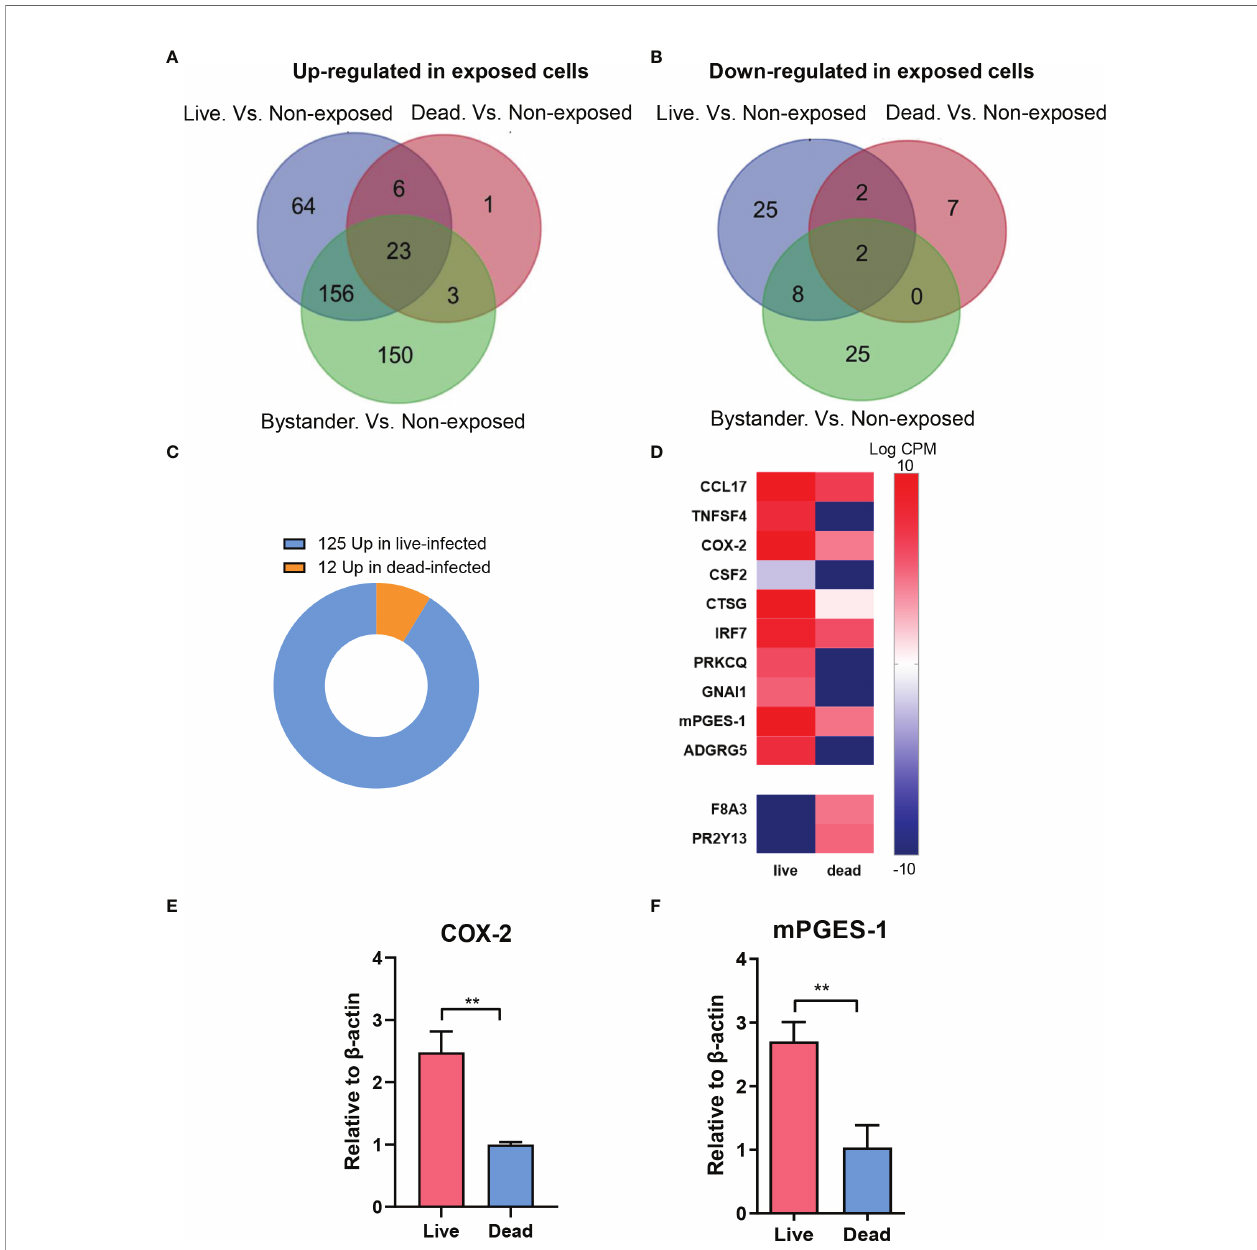
FIGURE 2 | Differential gene expression between live and dead M.tb -infected MDM. (A) Bystanders, live bacteria-infected and dead bacteria-infected M0 GM- CSF MDM (MDM) were compared with non-exposed cells, independently. Compared with non-exposed MDM, 332 and 249 genes were detected with higher expression levels in the bystander subgroup and live bacteria-infected subgroup, while 36 and 37 genes were detected with decreased expression, respectively (FDR < 0.05, fold change > 3). (B) MDM with dead bacteria showed 33 genes up-regulated and 12 genes down-regulated. In total, 23 genes always showed higher expression while 2 showed decreased levels in bacteria-exposed cells. (C) Totally, 137 differentially expressed genes were disclosed between live-infected and dead- infected MDM, with a majority (125/137, 91.2%) up-regulated and only a small subset (12/137, 8.8%) down-regulated in cells with live bacteria. (D) Up-regulated genes in MDM with live bacteria versus cells with dead bacteria, mainly related to immune processes, are shown in a heatmap. (E, F) Analysis of mRNA levels of COX-2 (E) and PTGES (F) in live bacteria- and dead bacteria-infected MDM. Relative mRNA levels are normalized to b -actin. Data were log-transformed for statistical analysis by paired t test. **p ≤